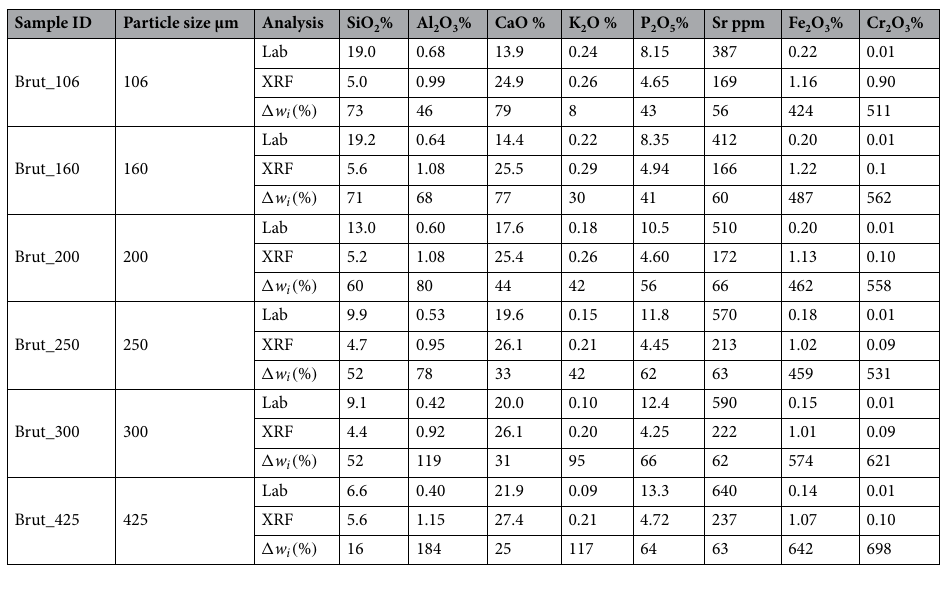
Table 4. Samples analysis of different grain sizes by external laboratories and by